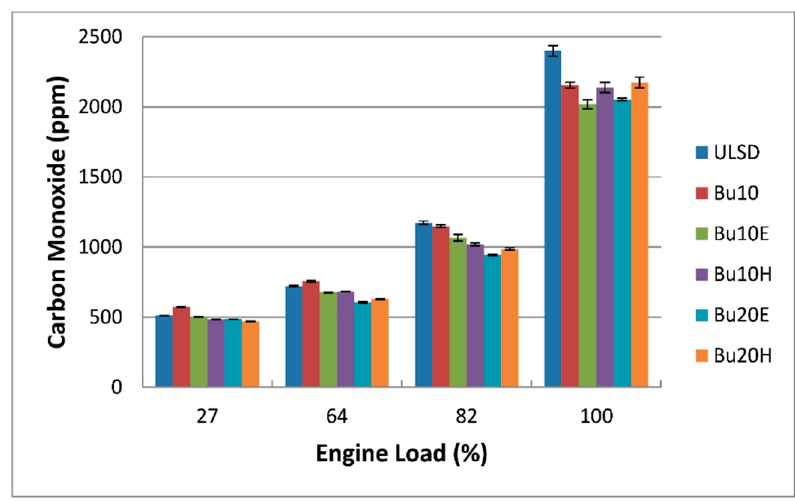
Figure 9. Carbon monoxide emissions of the six fuels with the same DCN.